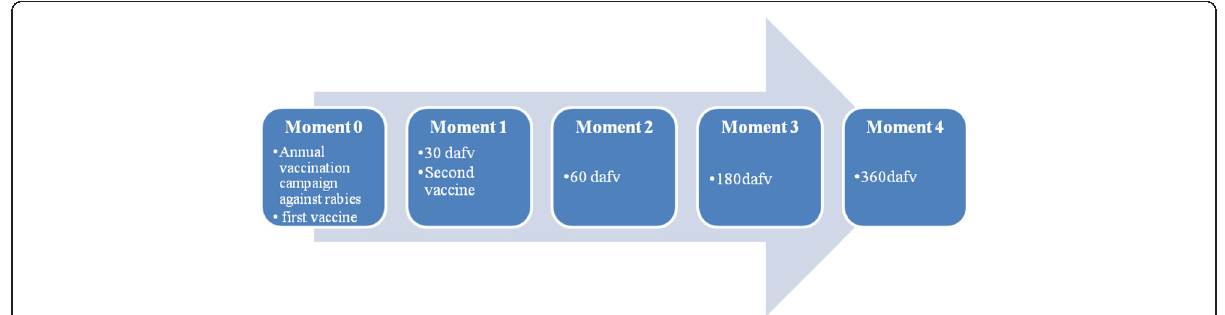
Figure 1 Experimental design of the present study.